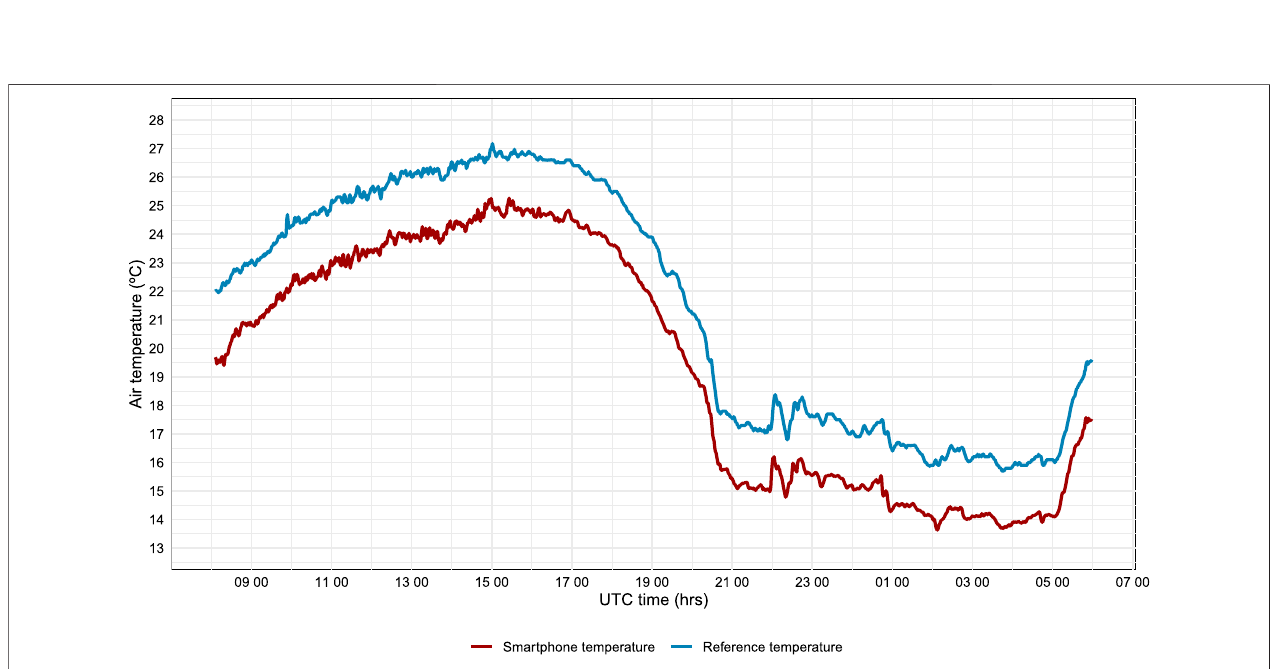
FIGURE 3 | Time series of observed air temperature from the smartphone and reference weather station Veenkampen. During this experiment the smartphone is located inside the Stevenson screen. The experiment was executed from January 27 th 2018 10:00 UTC till January 28 th 2018 10:00 UTC.